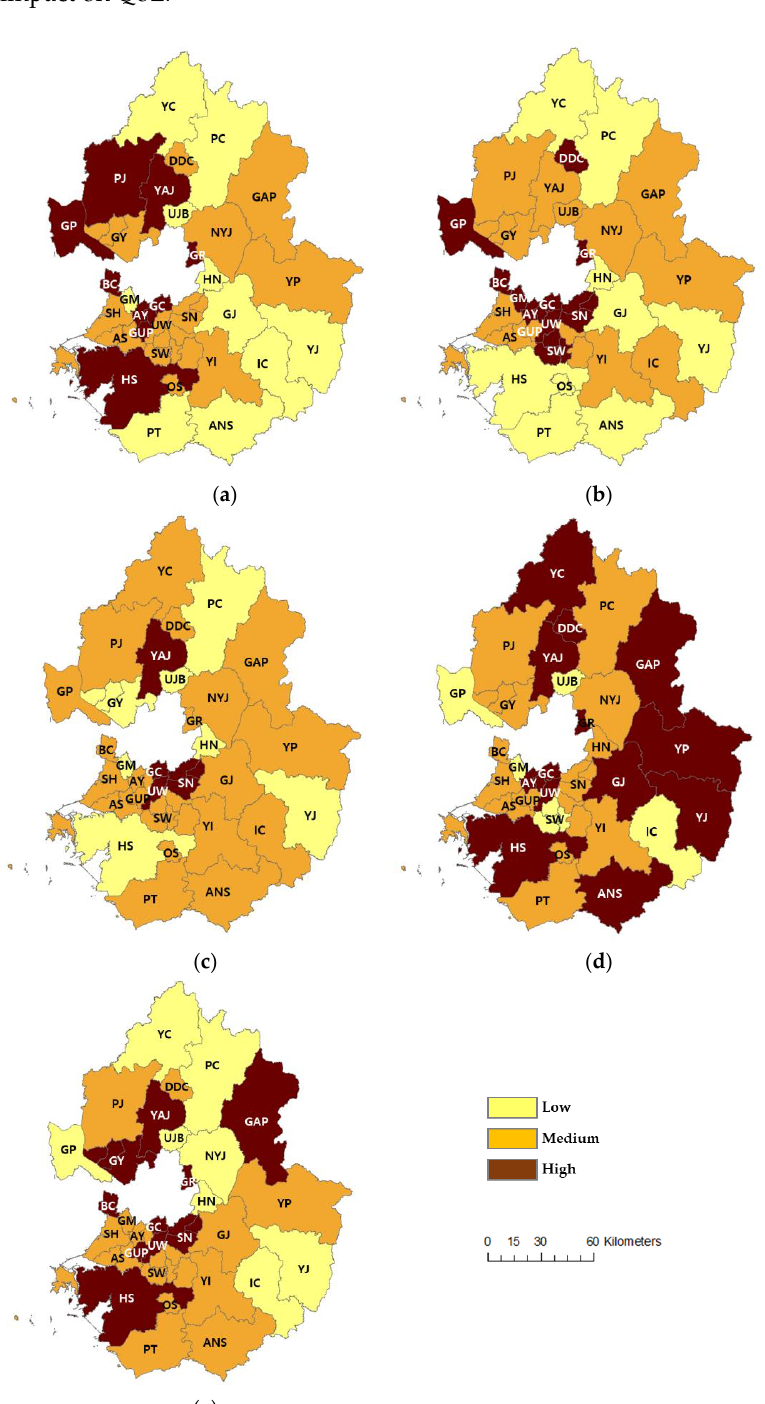
Figure 3. Spatial comparison for factors. ( a ) Facilities satisfaction; ( b ) Commuting satisfaction; ( c ) Safety satisfaction; ( d ) Neighborhood satisfaction; ( e ) Quality of life. Note: AS; Ansan, ANS; Anseong, AY; Anyang, BC; Bucheon, DDC; Dongducheon, GAP; Gapyeong, GP; Gimpo, GY; Goyang, GUP; Gunpo, GR; Guri, GC; Gwacheon, GJ; Gwangju, GM;